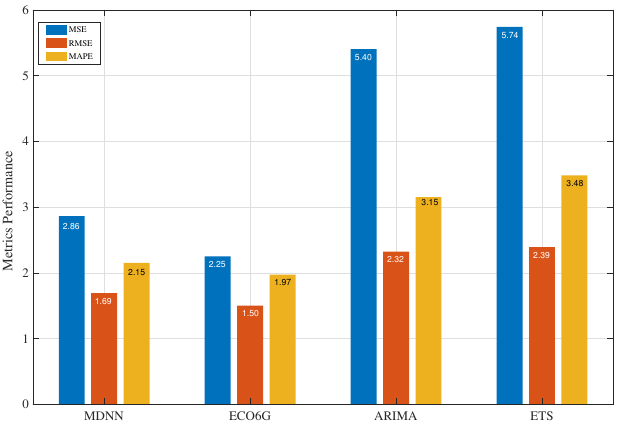
Figure 2. Model Evaluation and